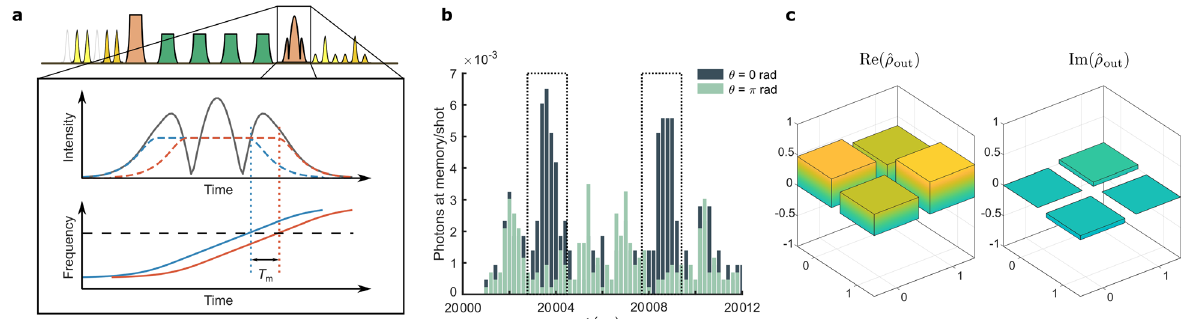
Fig. 4 Qubit tomography. a Projections for the tomography are implemented by choosing the appropriate pulse pro fi le for the second transfer pulse in the storage sequence. For projections in σ x and σ y the second transfer pulse takes the form of a composite HSH, obtained from the sum of the fi elds of two chirped pulses that are temporally shifted by the width of one time bin ( T m ) relatively to each other. In the top fi gure, the envelopes of the two partial pulses are shown with dashed lines and the resulting composite pulse with a solid line. As a consequence, each speci fi c frequency of the AFC (e.g., the dashed line in the bottom fi gure) is addressed at two different times separated by T m , as indicated by the crossings with the two solid lines. b Two examples of projection of the output state onto (light histogram) eigenstates of the σ x operator. The overlap is proportional to the amplitude in the interference bins (dotted boxes). The input state ψ in was prepared in the þj i eigenstate of σ x . c Reconstructed density matrix ^ ρ out of the output state. See Supplementary Note 4 for more